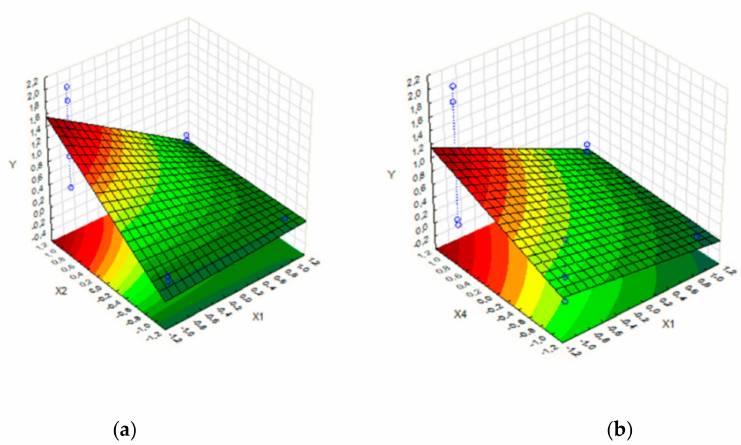
Figure 4. Response surface of factorial design: ( a ) variable X1 vs. X2; ( b ) variable X1 vs. X4. Assessing the immobilization yield, using a lower enzyme dose (1 / 313 enzyme / NPs at pH 8.0), the